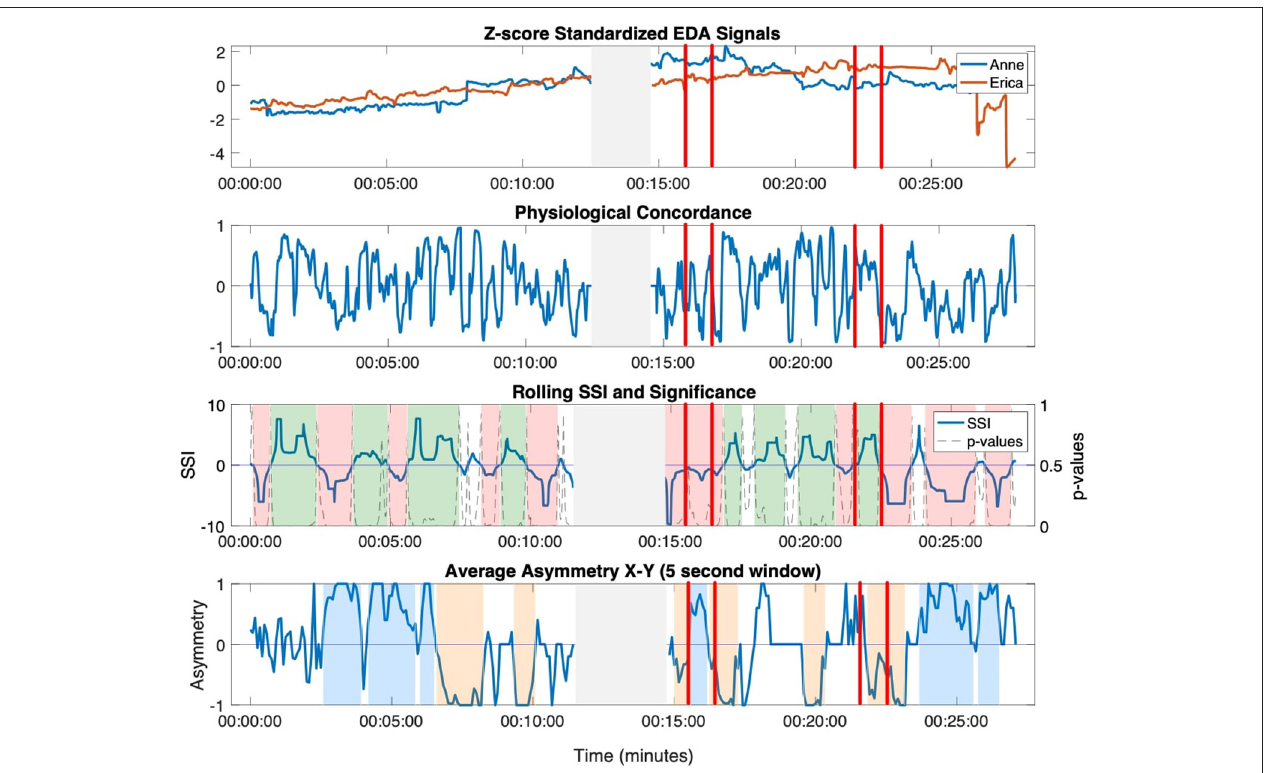
FIGURE 2 | Standardized EDA signals, physiological concordance, SSI, and asymmetry for an example dyad across the entire movement session. Physiological concordance was computed over a 15 s moving window; the SSI was computed over a 30 s moving window; and the asymmetry X → Y was computed as the average NSTE (computed with a 60 s moving window) in a 5 s window. Moments of interpersonal connection identified by the ethnographers are shown between the vertical red lines. Moments of sustained synchrony (at least 30 s) are highlighted in green (sustained positive SSI), red (sustained negative SSI), blue (sustained asymmetry X → Y ), orange (sustained asymmetry Y → X ). The gray shaded area in the middle of the session indicates the time interval where the sensor disconnected.